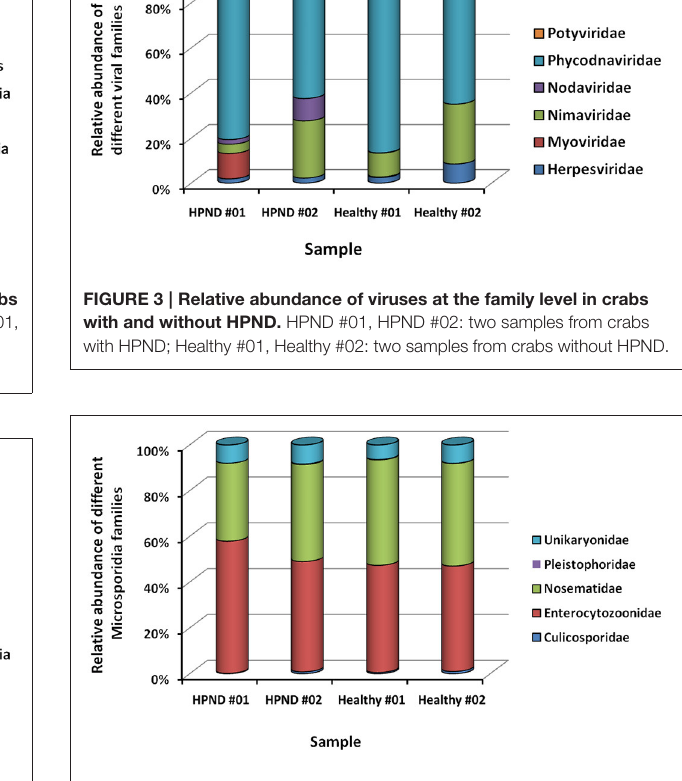
FIGURE 4 | Relative abundance of Microsporidia at the family level in crabs with and without HPND. HPND #01, HPND #02: two samples from crabs with HPND; Healthy #01, Healthy #02: two samples from crabs without